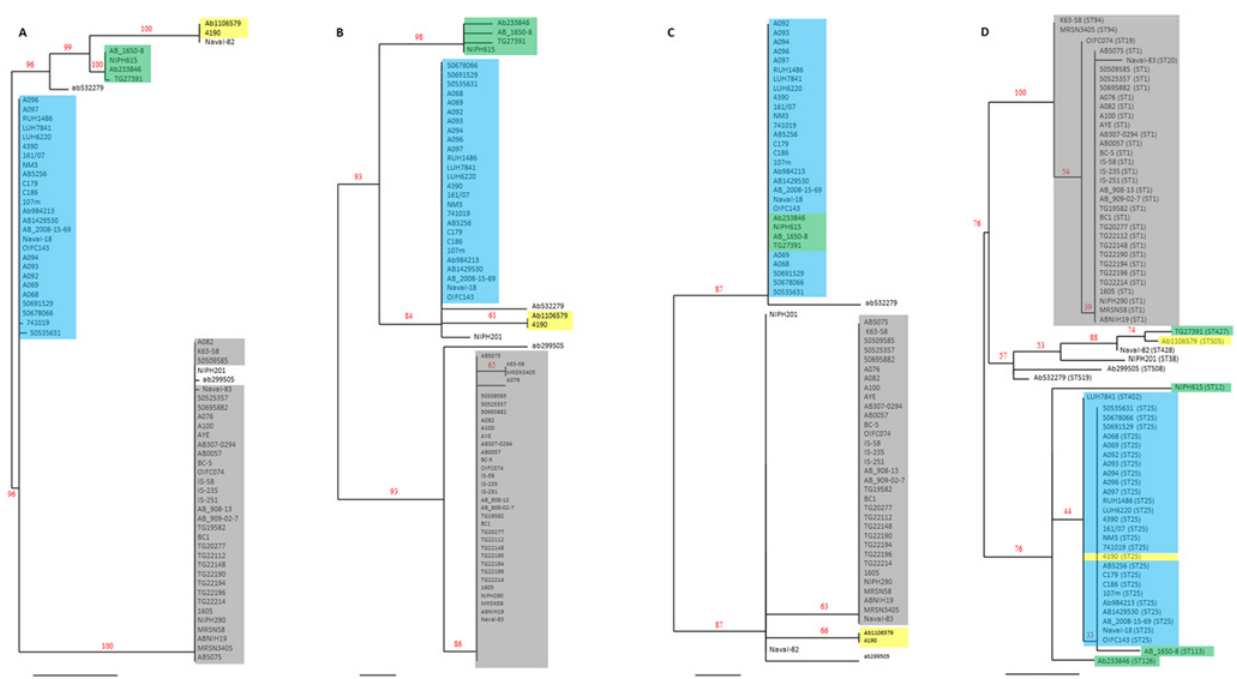
Fig 3. Phylogenetic trees of cas1 , csy1 , csy4 and the concatenated MLST sequences. The phylogenetic trees were based on aligned nucleotide sequences of ( A ) 920 bp of cas1 from 69 isolates of Acinetobacter baumannii , ( B ) 1251 bp of csy-1 from 68 isolates of A . baumannii since csy1 was lacking in isolate Naval-82, ( C ) 615 bp of csy4 from 69 isolates of A . baumannii , and ( D ) 2976 bp of concatenated MLST sequences of 69 isolates of A . baumannii . MUSCLE, Gblocks, PhyML, and TreeDyn were used for nucleotide alignment and tree construction. One hundred bootstraps were used for bootstrap analysis. Branch support values were displayed in %. Isolates of the CRISPR- cas subtype I-Fb pathways of evolution 1, 2, 3, and 4 were highlighted in gray, blue, green, and yellow, respectively. The corresponding sequence type (ST) was presented next to the name of each isolate in ( D